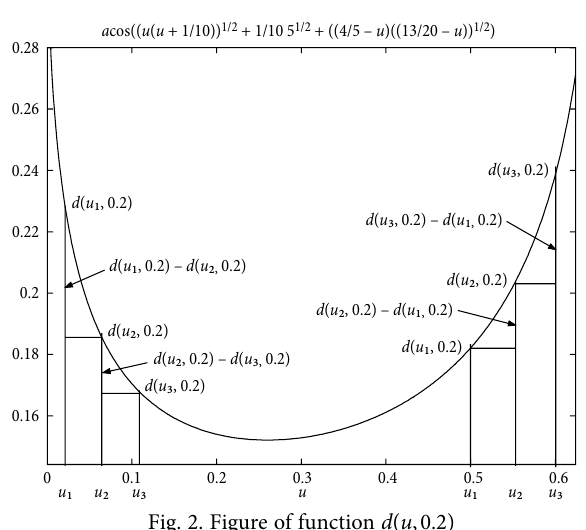
Fig. 2. Figure of function d ( u ,